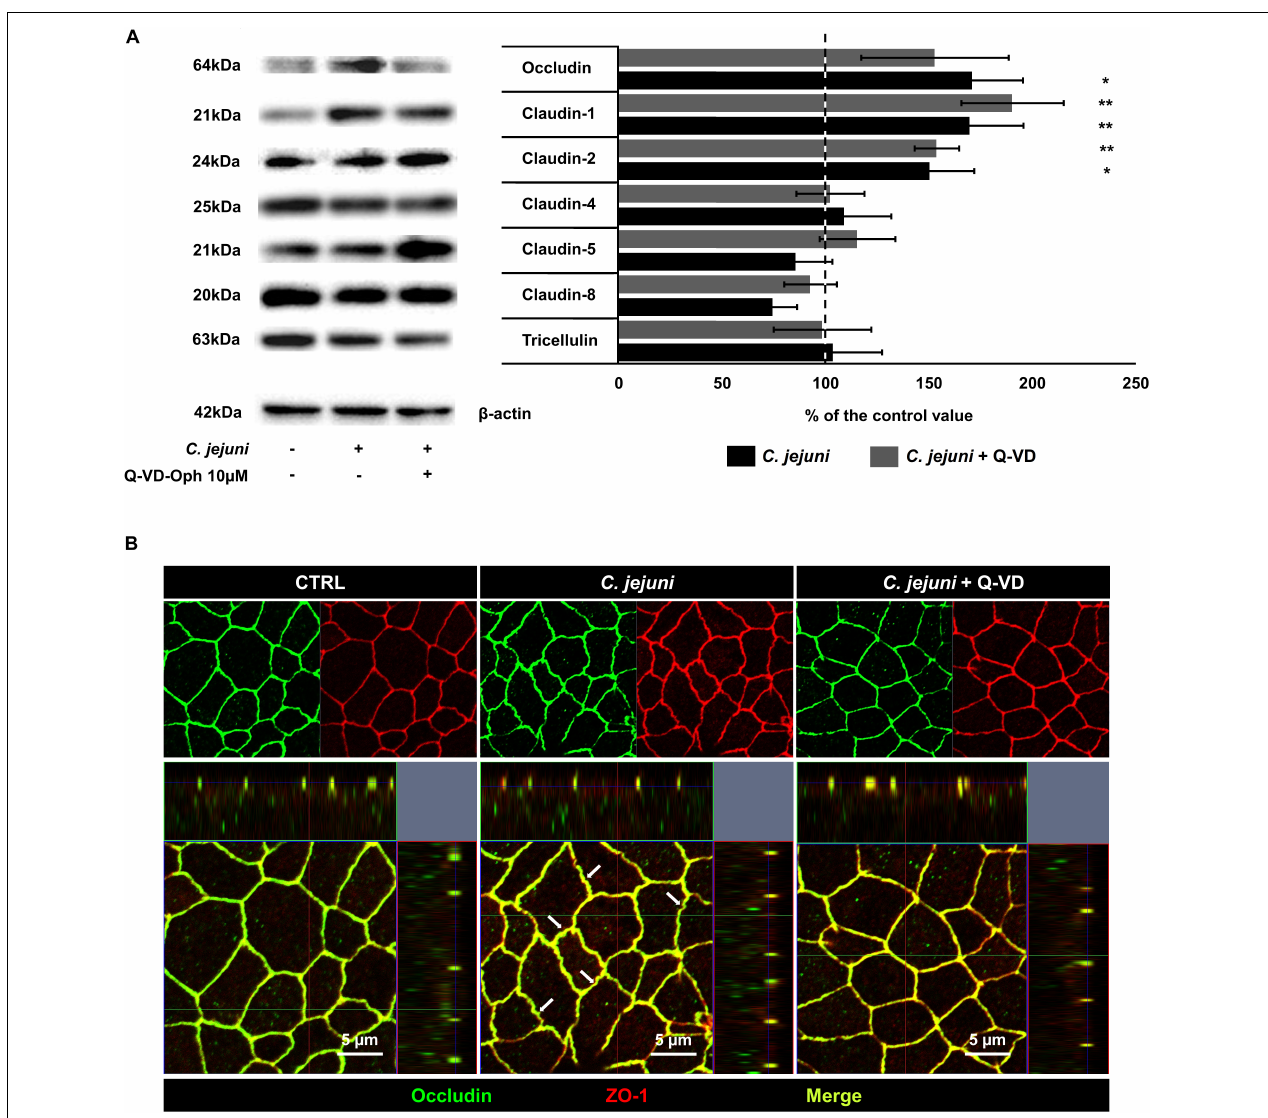
FIGURE 4 | Expression of tight junction proteins in C. jejuni -infected co-cultures 22 h post-infection. Co-cultures of HT-29/B6-GR/MR and THP-1- cells were infected with C. jejuni with or without apoptosis inhibitor Q-VD-OPh. (A) Western blot was performed on the cell lysates 22 h after infection. Expression level of tight junction proteins was normalized with β -actin. Immunoblots were subjected to densitometric analysis. The dashed line represents control value set to 100%. Q-VD-OPh control treatment did not change the expression level of the described tight junction proteins compared to untreated controls (data not shown). Data are presented as mean values in percent of the control values, ± SEM. n = 7–9, * p < 0.05, ** p < 0.01, unpaired Student’s t -test with Bonferroni-Holm adjustment for multiple comparisons. (B) The cell monolayers were analyzed by confocal microscopy after immunofluorescence staining. The micrographs show the localization of the tight junction proteins occludin (green) and zonula occludens protein-1; ZO-1 (red) at cell borders. The merge (yellow) image represents the co-localization of the tight junction proteins in a single plane of a Z -stack. White arrows indicate zigzag pattern of bicellular cell-cell contacts in C. jejuni -infected